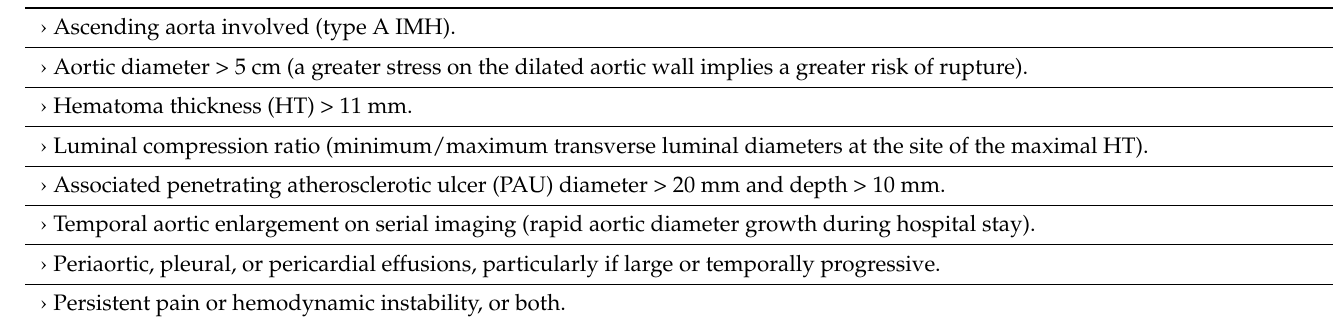
Table 5. MDCT and clinical features suggesting risk of progression of